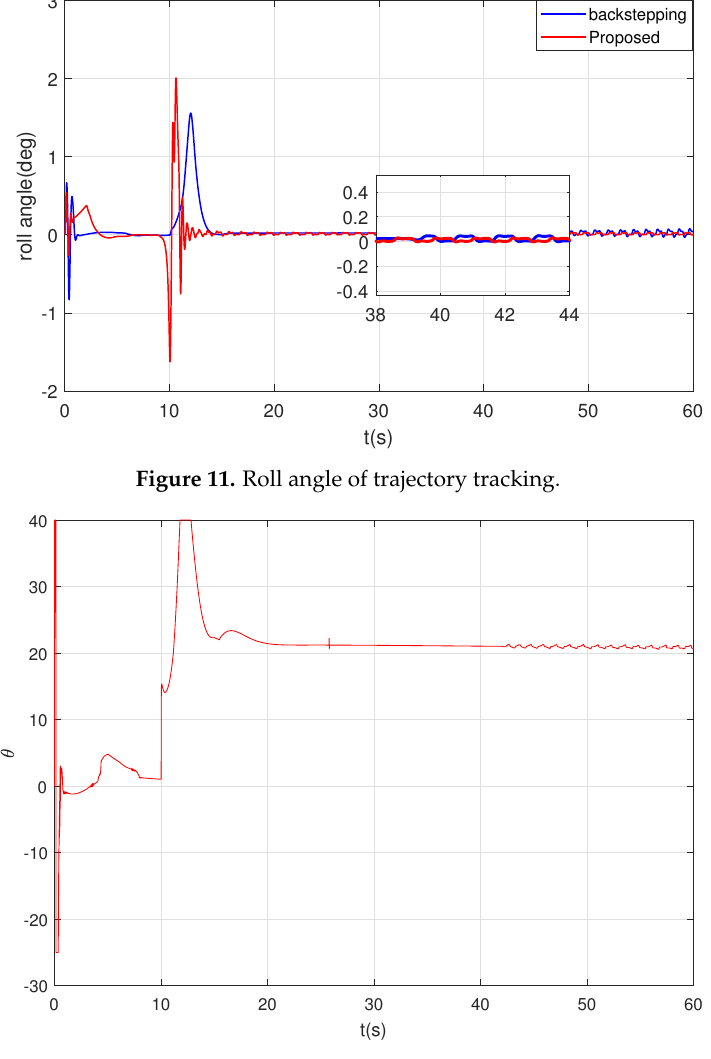
Figure 12. Pitch angle of the air propeller.